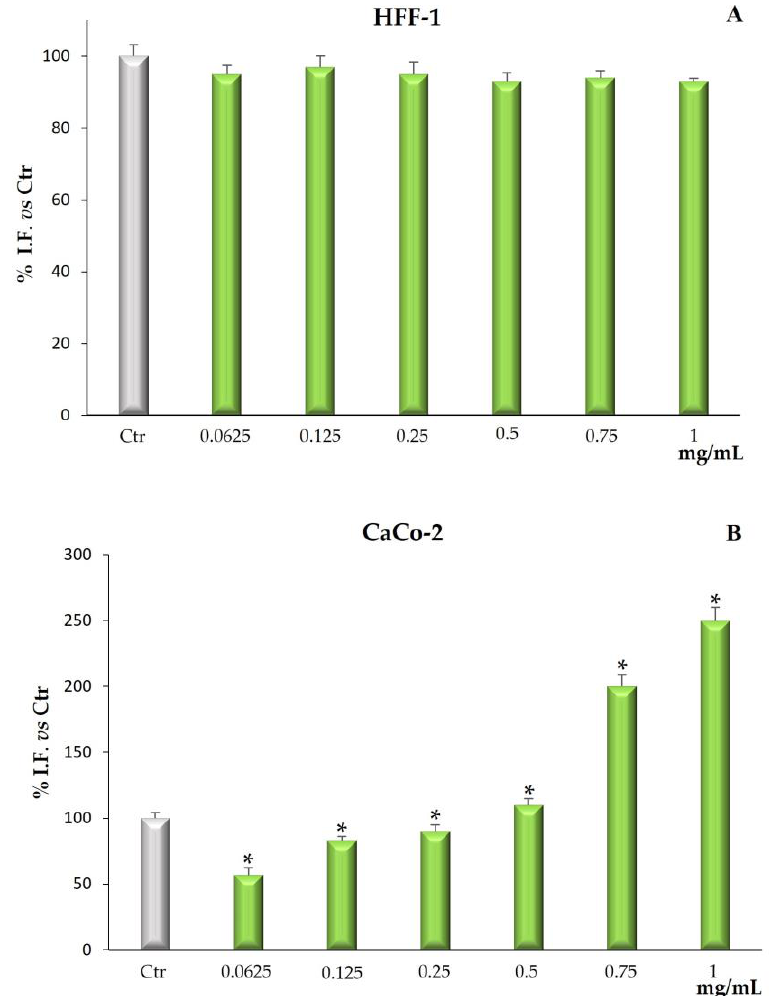
Figure 5. ROS levels in HFF-1 ( A ) and CaCo-2 ( B ) cells untreated and treated for 72 h with Bff -EAF at different concentrations (0.0625–1 mg/mL). Values are the mean ± SD of four experiments in triplicate. * Significant vs. untreated control cells: p < 0.001.